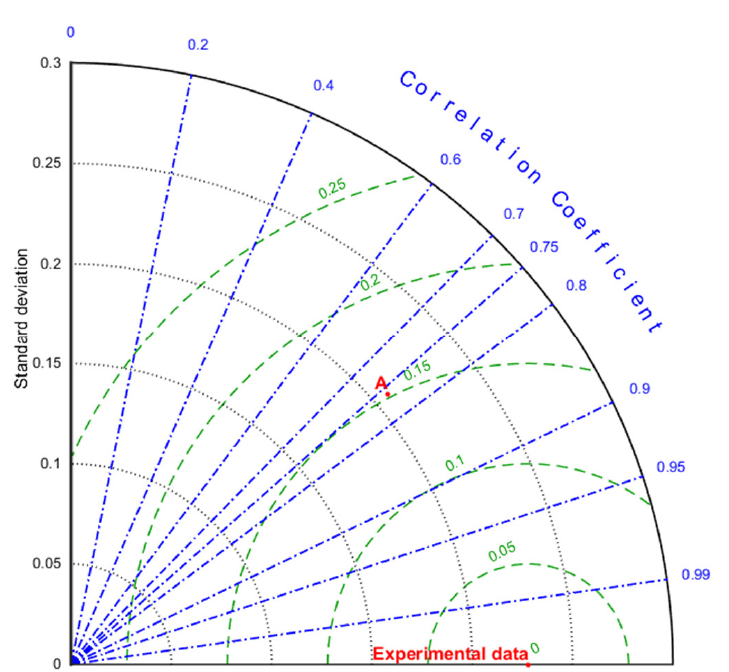
Figure 11. Statistical comparison of (Dashed blue: coorelation, Dashed black: standard deviation, Dashed green: RMS error) the current model estimates the C D (the point “A”) with observations of previous researchers (the point “Experimental data”).